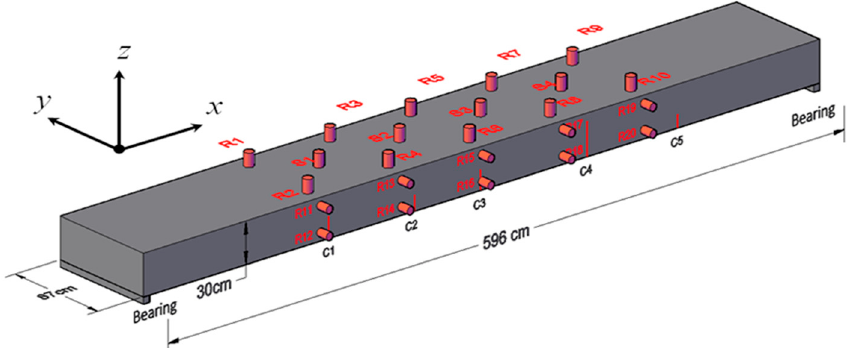
Figure 1. Ultrasonic transducer setup. S1~S4 label the source positions and R1~R20 label the receiver positions.